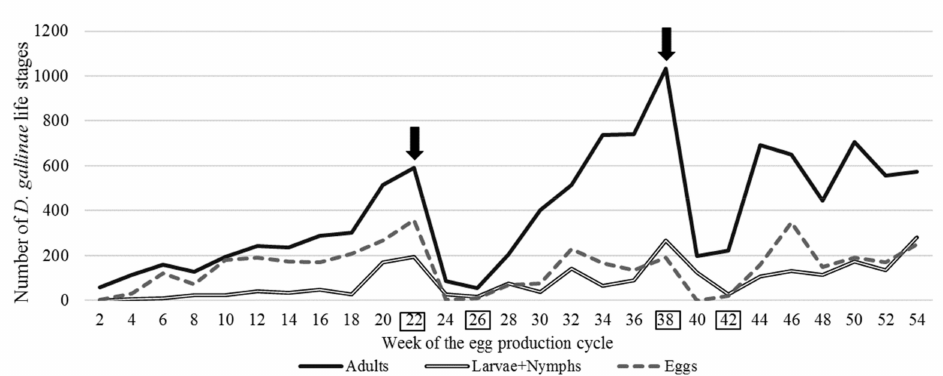
Figure 1. The size of the Dermanyssus gallinae population and its life stages following two applications of the acaricide product Biobeck PA 910 (AI silicon dioxide, Biologische Preparate, Brilon, Germany) during a 54-week production cycle. (Mite treatment MTI and MTII dates are marked by arrows, blood sampling B1–4 dates are marked by